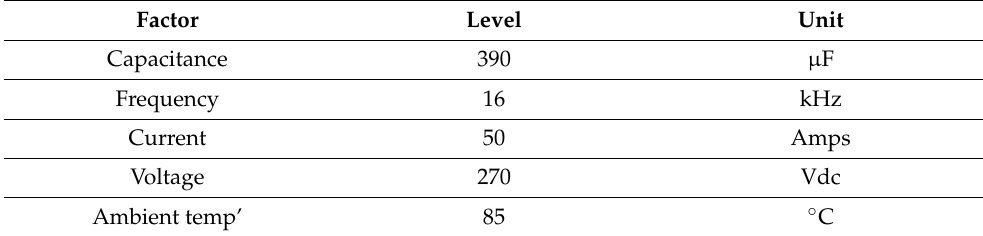
Figure 8. Optimization conditions sample. Table 8. Parameters used in the temperature experiment.